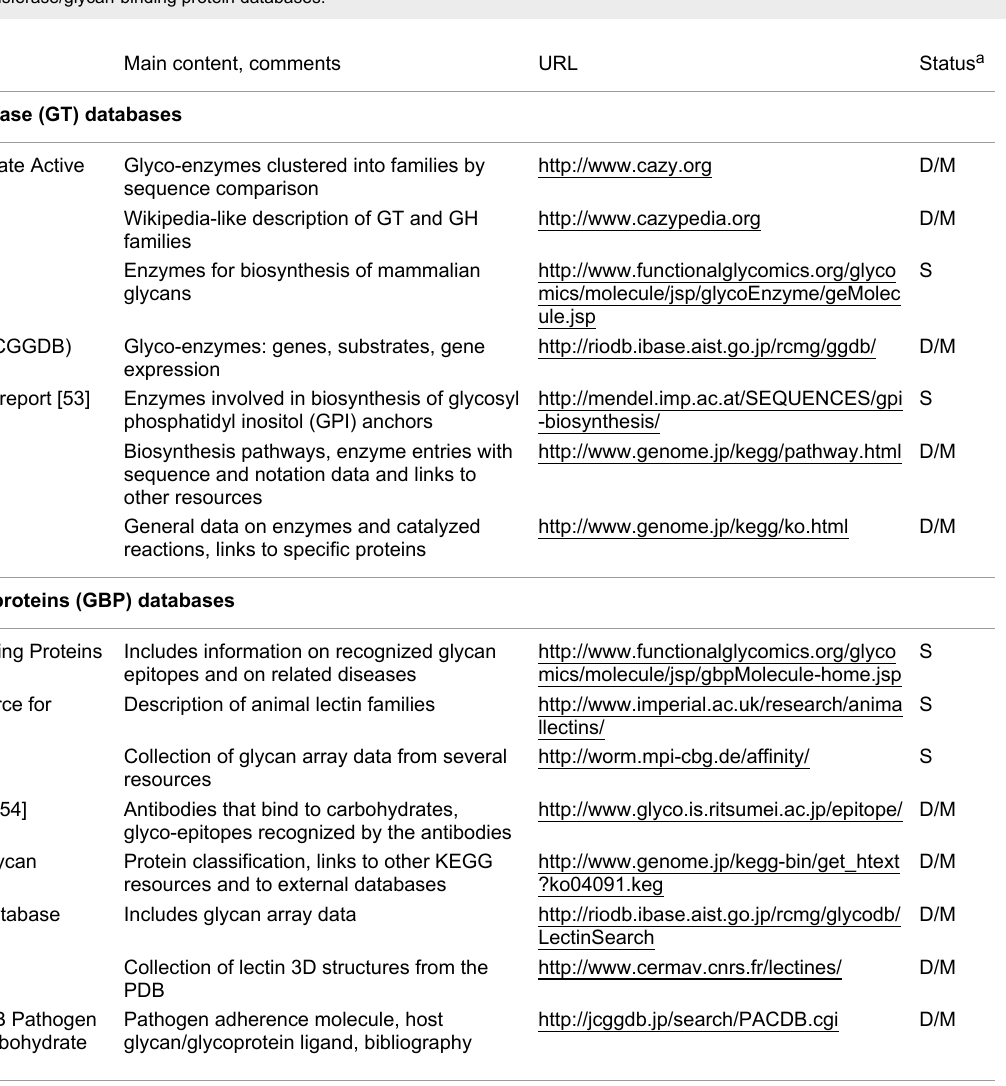
Table 2: Glycosyltransferase/glycan-binding protein